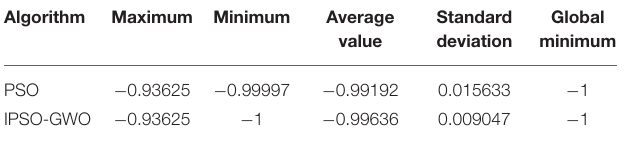
TABLE 7 | Easom function test results.